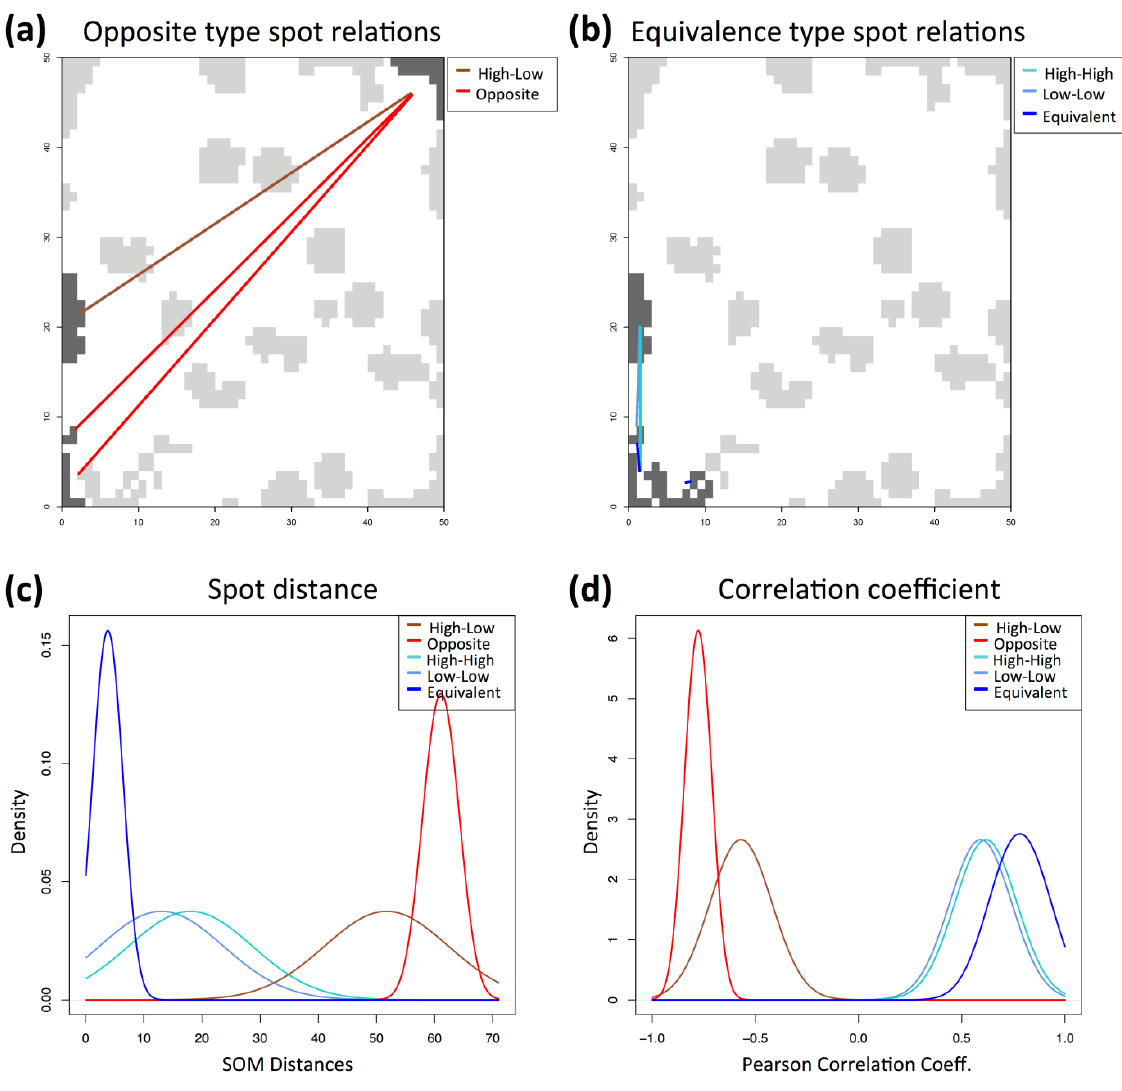
Figure 9: Spot module relations based on spot expression profiles. See description of Figure-7 for further